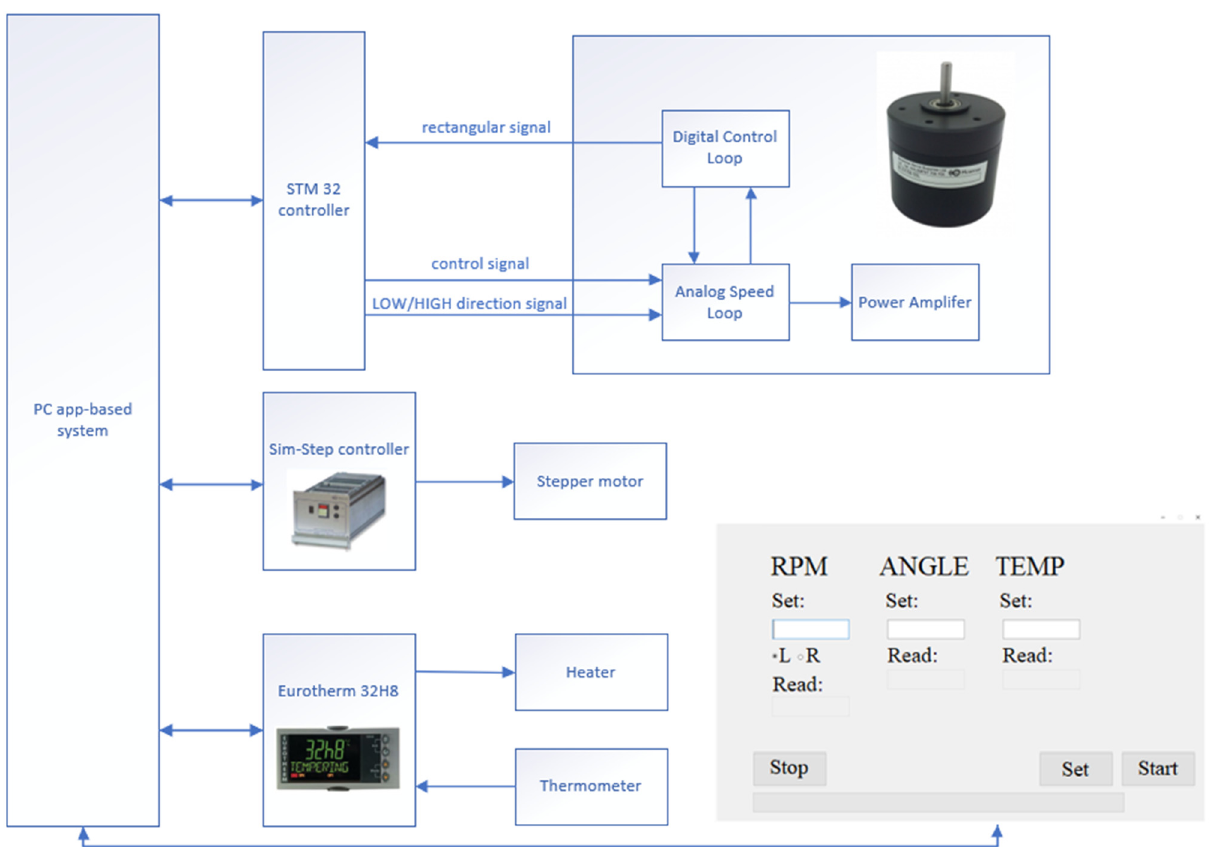
Figure 10. The connection of the GLAD machine controller.